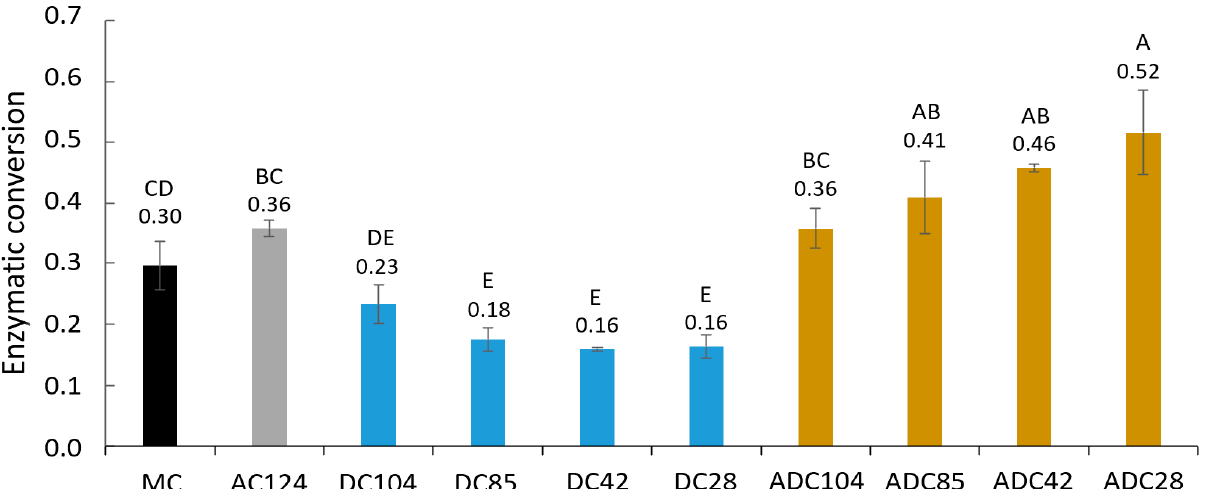
Figure 3. Enzymatic conversion degree after 1 h hydrolysis with Cellic CTec2 enzyme blend for microcrystalline cellulose (MC), amorphized cellulose (AC124), depolymerized cellulose (DC) and amorphized depolymerized cellulose (ADC) with a different average degree of polymerization. ACxx, DCxx or ADCxx represents AC, DC or ADC with an average degree of polymerization of xx. Different letters indicate significant differences ( p < 0.05).